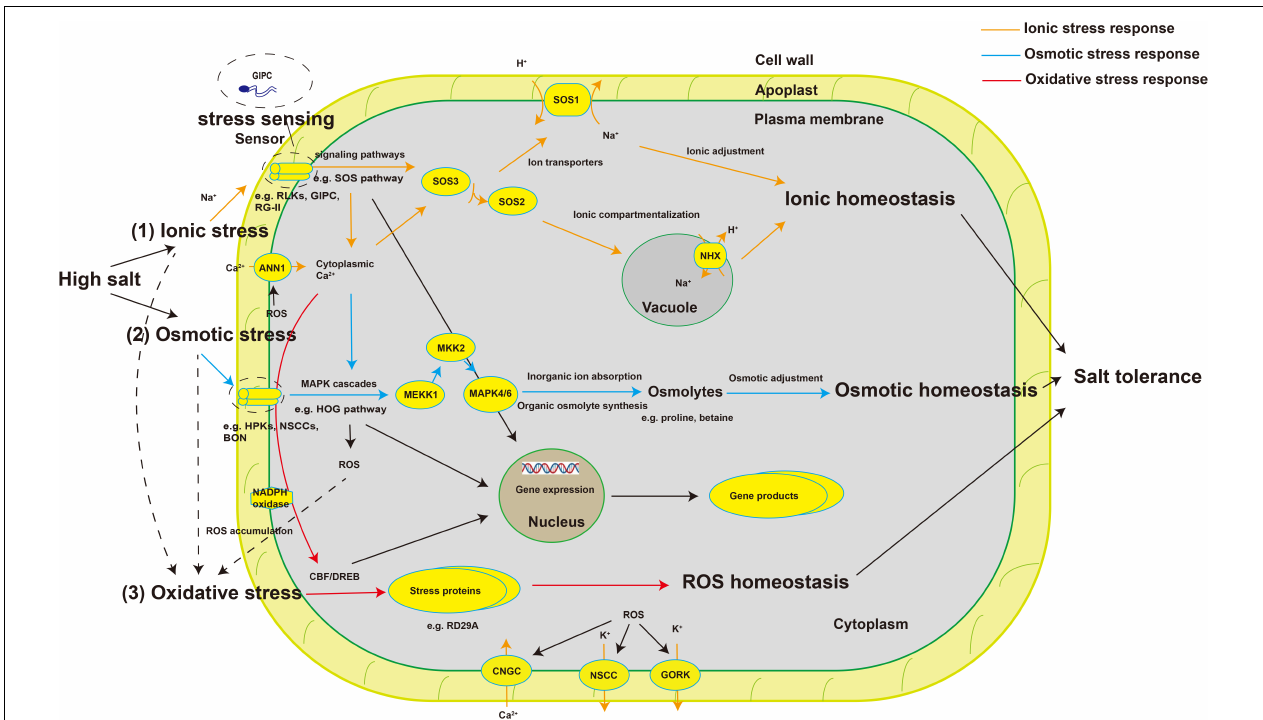
FIGURE 1 | Schematic diagram of plant salt-stress sensors and signal transduction pathways involved in salt stress responses. High salt stress causes osmotic stress and ionic stress, both of which lead to the accumulation of ROS, triggering oxidative stress. (1) High concentrations of salt ions alter the concentration of ions in the cell wall, which are sensed by specific sensors or receptors (such as RLKs, GIPC, and FER), which activate signaling pathways such as the SOS pathway to redistribute ions and achieve ion homeostasis. (2) Changes in the balance between ion concentrations inside and outside the cell change the cell’s osmotic potential. The cell senses these changes through specific sensors (such as HPKs, NSCCs, and BON) and, through MAPK cascades (such as the HOG pathway), regulates the synthesis of organic osmolytes (such as proline and betaine) and the absorption of ions to achieve osmotic homeostasis. (3) The accumulation of ROS generated by plasma membrane–bound NADPH oxidase under salinity leads to secondary oxidative stress. Transcription factors such as CBF/DREB regulate the synthesis of some stress proteins (such as RD29A) to deal with the damage caused by secondary metabolites and achieve ROS homeostasis. Finally, salt tolerance is achieved through the synergy of various signaling pathways and the expression of salt tolerance–related genes. ROS, reactive oxygen species; RLKs, receptor-like protein kinases; GIPC, glycosyl inositol phosphorylceramide; FER, FERONIA; HPKs, histidine protein kinases; NSCCs, non-selective cation channels; BON, BONZAI1; SOS pathway, Salt Overly Sensitive pathway; MAPK cascades, mitogen-activated protein kinase cascades; HOG pathway, high-osmolarity glycerol pathway; NADPH, nicotinamide adenine dinucleotide phosphaten; CBF, CRT/DRE-binding factor; DREB, dehydration responsive element binding protein; ANN1, ANNEXIN1; CNGC, cyclic nucleotide-gated channel; GORK, Guard Cell Outward-Rectifying Potassium Channel; NHX, Na + /H +